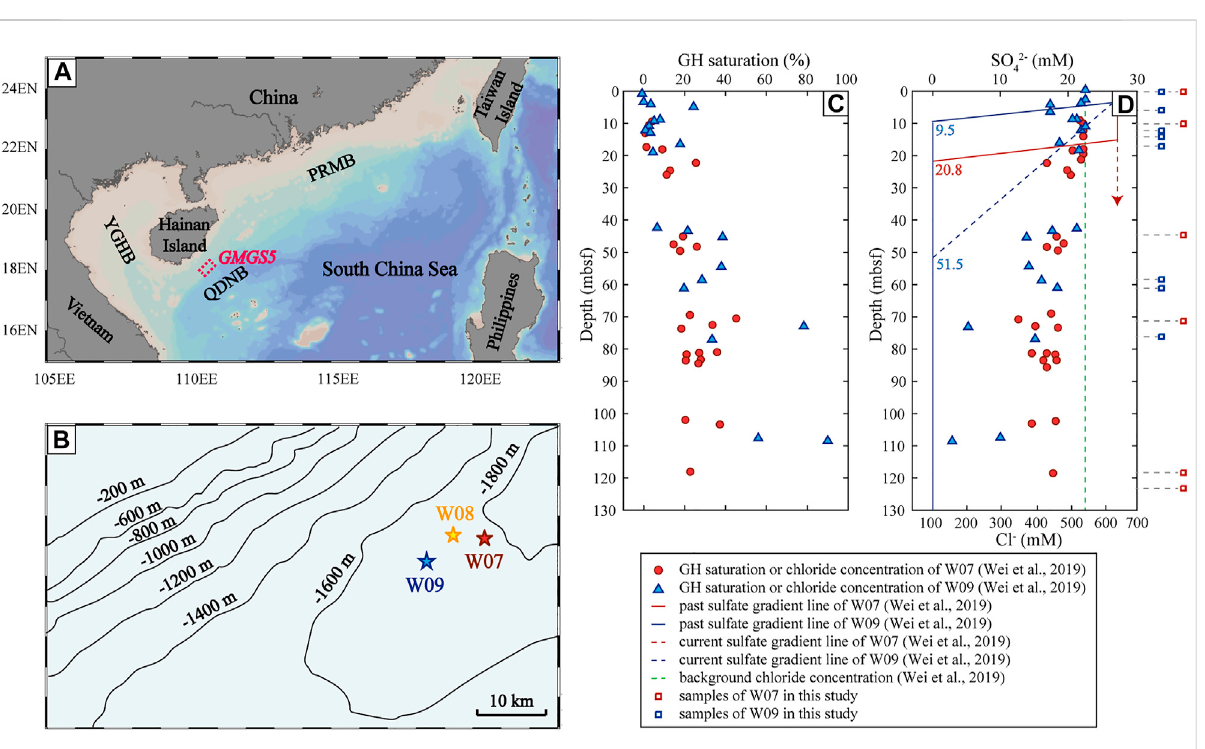
FIGURE 1 Gap of sampling locations and gas hydrate saturation of research sites in this study. (A) Geological settings and location of GMGS5 drilling area (red dotted frame). QDNB: Qiongdongnan Basin, YGHB: Yinggehai Basin, PRMB: Pearl River Mouth Basin. (B) Submarine topography of study area and locations of sitesduring GMGS5 (pointedstars, after Liang etal., 2019). (C) Gashydrate saturation calculated based on chlorideconcentration of site W07 and W09 from Wei et al. (2019). (D) Chloride concentration and sulfate pro fi les of site W07 and W09 from Wei et al. (2019), and the depth of experimental samples in this